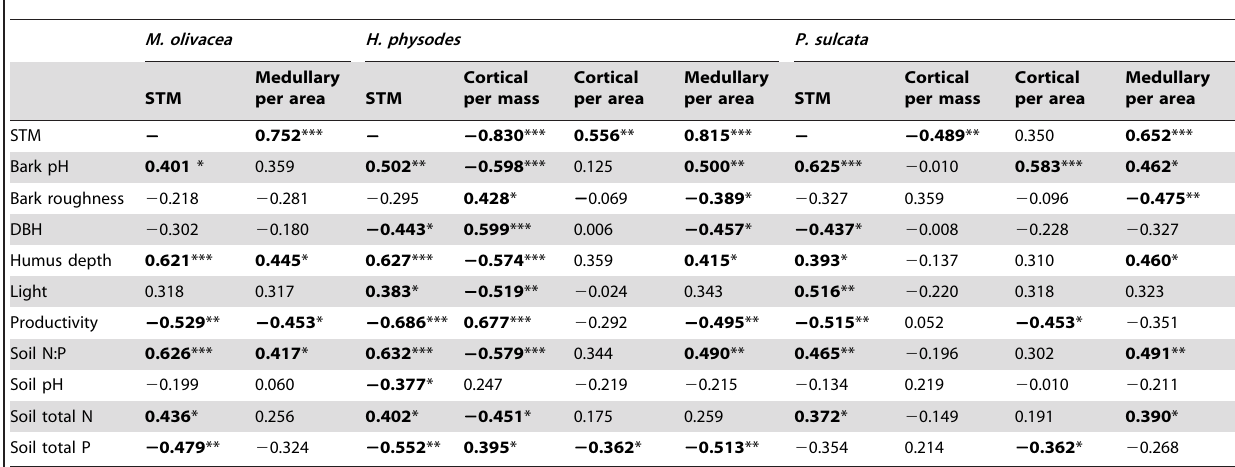
Table 2. Relationships between lichen traits and environmental variables.